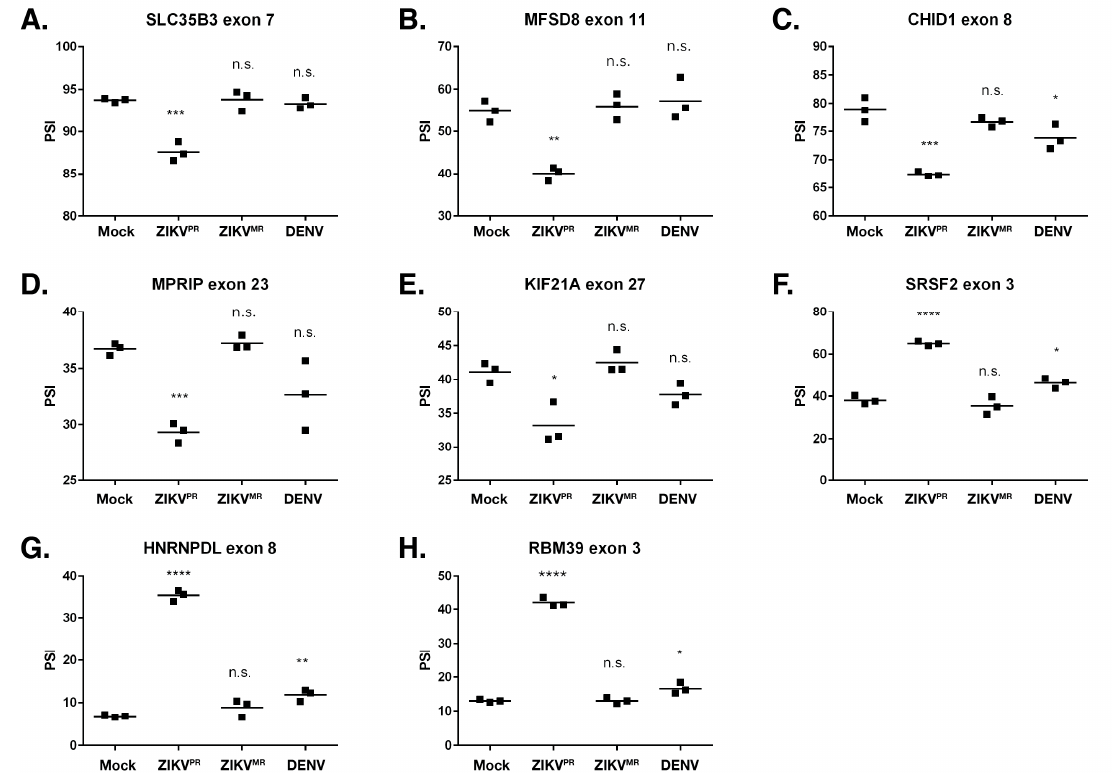
Figure 5. Validation of select alternative splicing events in mock-, ZIKV PR -, ZIKV MR -, and DENV2-infected SH-SY5Y cells. ( A – H ) RNA from each of the three biological replicates was used for RT-PCR for the indicated gene. The percent spliced in (PSI) was calculated as described in the Materials and Methods. PSI indicates the change in the inclusion of a regulated exon. The significance of the data was determined from three independent experiments using the GraphPad software and performing an unpaired Student’s t-test; n.s. denotes not significant, * p < 0.05, ** p < 0.01, *** p < 0.001, and **** p < 0.0001. Figure S6 shows the corresponding schematics of the gene exons examined as well as the RT-PCR products and Sashimi plots for the genes analyzed in this figure. Figure S7 shows the correlation between the PSI values obtained from RNA-seq and RT-PCR.